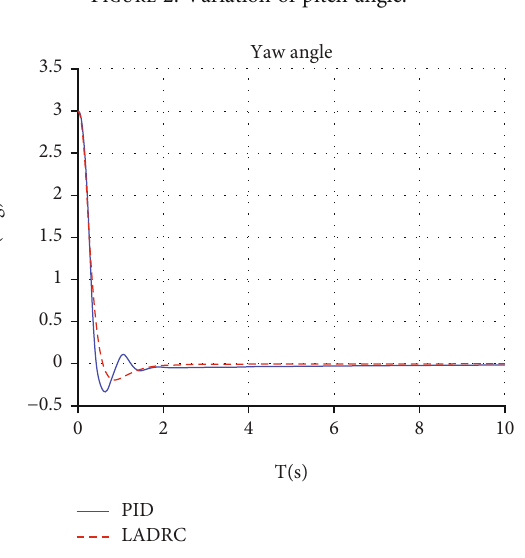
Figure 2: Variation of pitch angle.